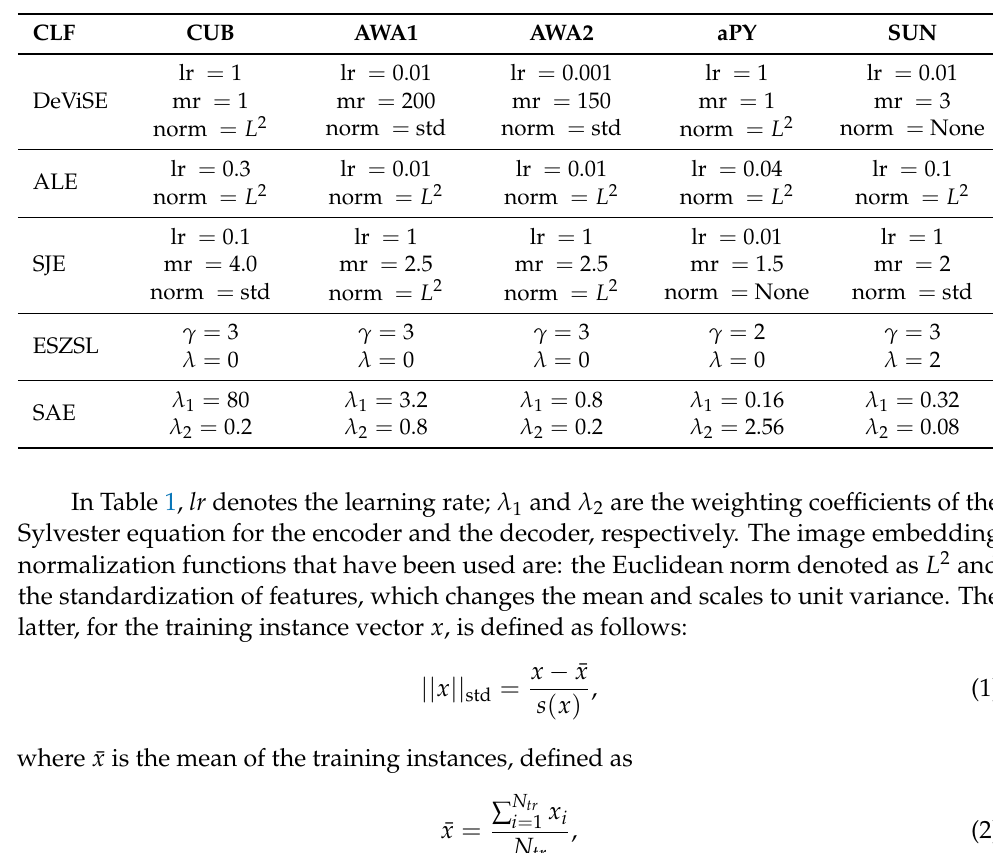
Table 1. Hyperparameters used in experiments for each individual classifier and